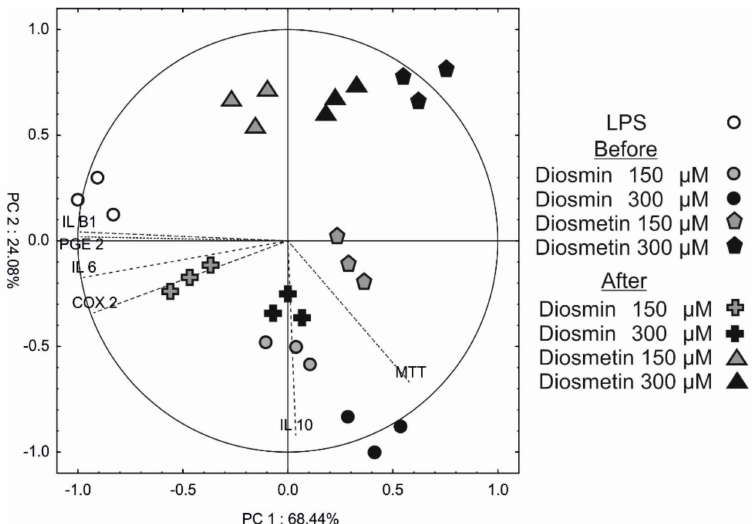
Figure 6. Scatter plot of principal component analysis of MTT, interleukins, PGE-2, and COX-2 in in human fibroblast cells treated with LPS only and with diosmin or diosmetin 2 h prior to or 24 h after LPS stimulation. The length of the dotted lines shows a correlation between original data and PC